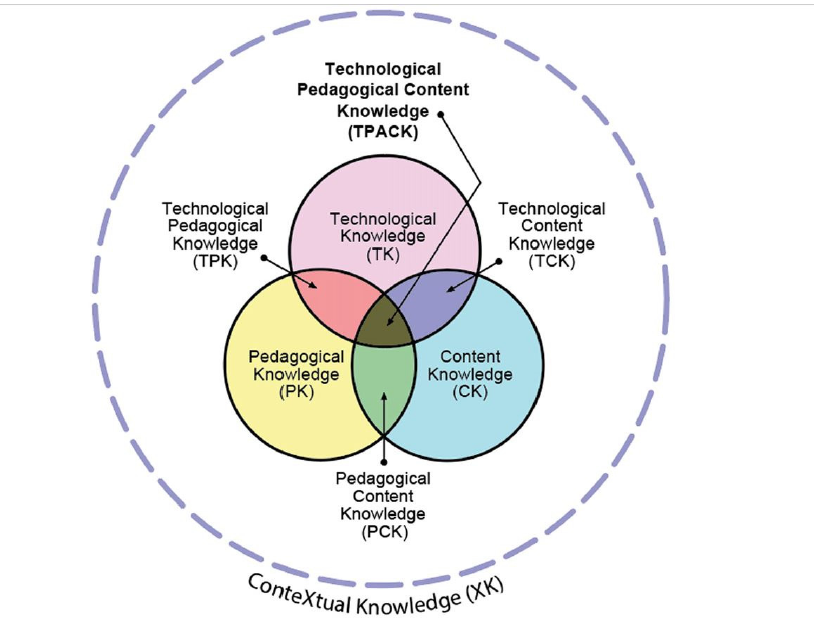
Figure 1. The New and Improved TPACK model. Revised version of the TPACK image. © Punya Mishra, 2018 [59]. Reproduced with permission.